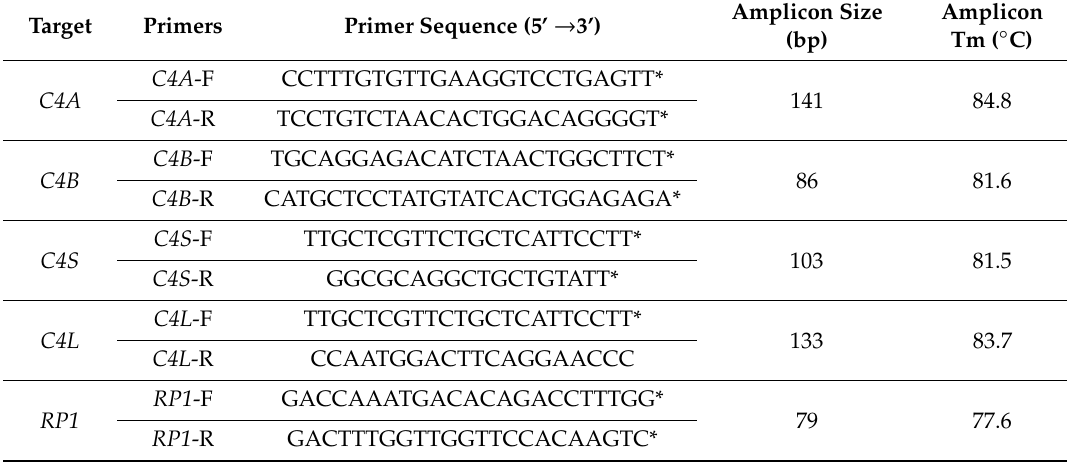
Table 2. C4 gene primers designed and selected for the HRM-PCR / GRACE-PCR assay. Amplicon size and melting